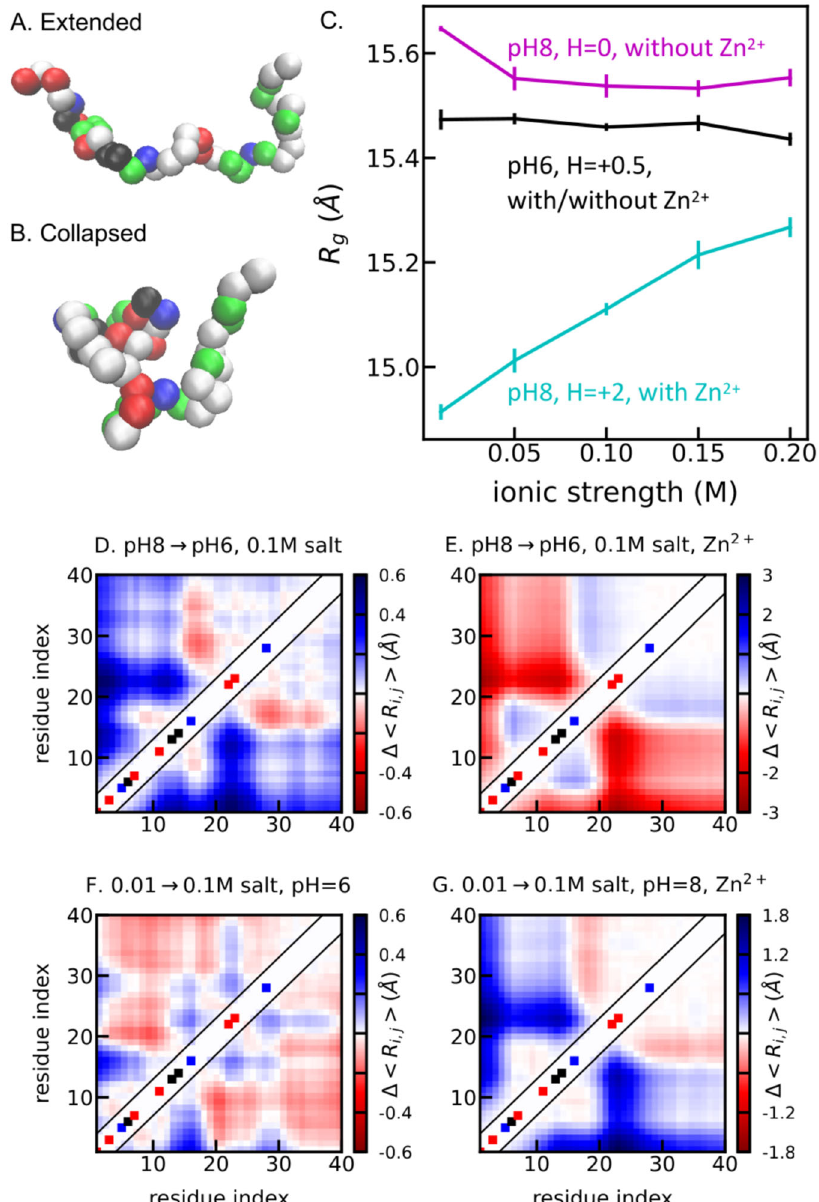
Fig. 3 Size of A β 40 from coarse-grained simulations at different ionic strength. A , B Two representative con fi gurations with different radii of gyration ( R g ). Positively charged amino acids are highlighted in blue, negatively charged amino acids in red, Histidine in black, polar amino acids in green and nonpolar amino acids in white. C R g from simulations for different conditions. Histidine is set to have different charges to model the effect of pH and Zn 2 + ions: + 0.5 for pH 6 with and without Zn 2 + (black); 0 for pH 8 without Zn 2 + (magenta); and + 2 for pH = 8 with Zn 2 + (cyan). D The difference of root mean squared distances ( Δ R i,j ) between simulations at pH 8 and 6 at the same ionic strength of 0.1 M without Zn 2 + ions. Blue colors indicate larger distances between the i-th and j-th amino acids and red colors indicate smaller distances when increasing pH. E Δ R i,j between pH = 8 and pH = 6 at the same ionic strength of 0.1 M with Zn 2 + ions. F Δ R i,j between ionic strengths of 0.1 M and 0.01 M at the same pH = 6 without Zn 2 + ions. G Δ R i,j between ionic strengths of 0.1 M and 0.01 M at the same pH 8 with Zn 2 + ions. Colors in the diagonal of D – G show the positively (blue) and negatively (red) charged amino acids, and Histidine (black). The error bars of the simulation results are estimated using a block averaging method with fi ve To get further insight into the microscopic mechanisms of data of A β 40 at pH 7.4 in the absence of NaCl and Zn 2 + ions A β 40 fi brillation at different pH values and NaCl concentrations, before the global fi t analysis (Fig. S2). A set of parameters, a global fi t analysis of the ThT kinetic data in the absence of Zn 2 + including the primary nucleation rate constant ( k ) = 0.00047 in n ions was conducted with an integrated rate law 25 – 28 by using the concentration − nc + 1 time − 1 (nc is the reaction order of primary AmyloFit online software server 29 . Amyloid proteins usually nucleation that simply interprets a nucleus size), the secondary undergo aggregation via either primary or secondary dominated ) = 4e + 7 in concentration − n2 time − 1 nucleation rate constant ( k 2 pathways 26,30 and A β 40 fi brillation is mainly dominated by (n 2 is the reaction order of secondary nucleation), and secondary nucleation processes 30,31 . Therefore, we selected the the elongation rate constant ( k þ ) = 9.49e + 8 in concentration − 1 secondary nucleation dominated model and fi rst fi tted the ThT time − 1 of A β 40 fi brillation process were obtained and used as the